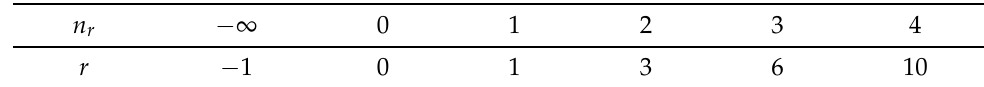
Figure 6. Schematic of MDP in the game of Tetris. Table 1. Number of cleared lines and